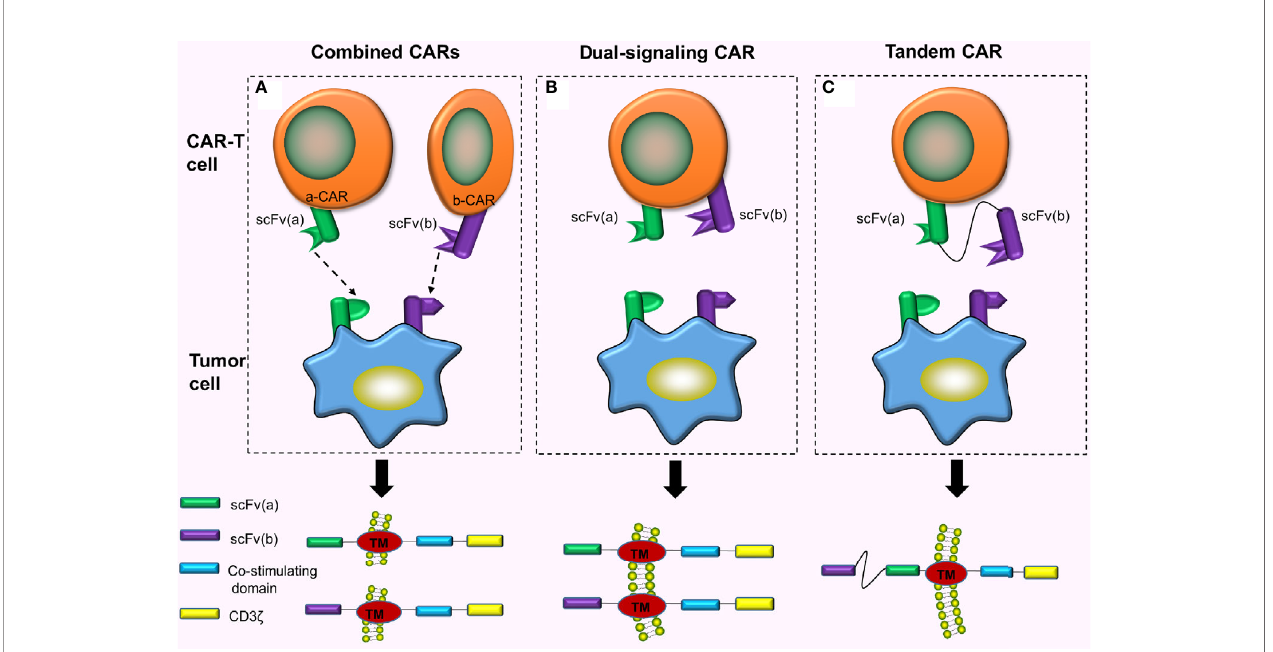
FIGURE 2 | Combined CARs, Dual-singling CAR and Tandem CAR. (A) Simultaneous or sequential use of 2 or more CAR-T cells treating a similar malignant tumor; (B) Dual-signaling CAR refers to the simultaneous and separate expression of 2 different CARs on similar T cell surface; (C) Two different scFvs are connected hand in hand to form tandem CAR on the surface of the T